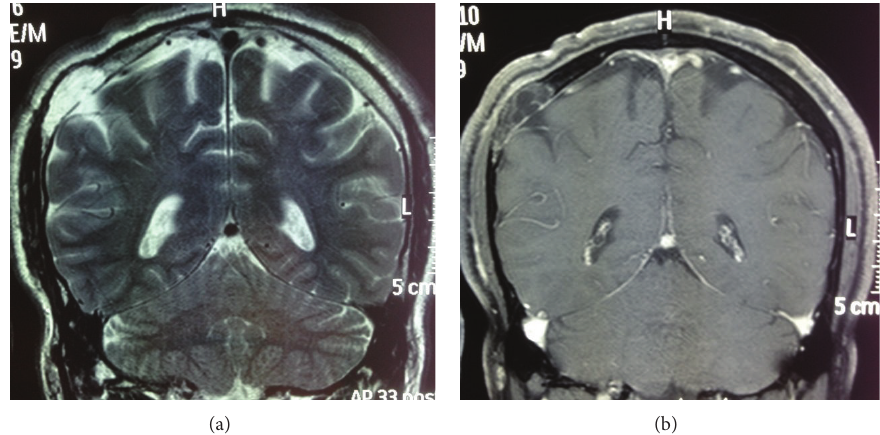
Figure 2: (a) T2 MRI showing high signal within the intraosseous lipomatous meningioma and dural defect. (b) T1 MRI with gadolinium observing heterogenous uptake within the lipomatous meningioma with no obvious intraparenchymal